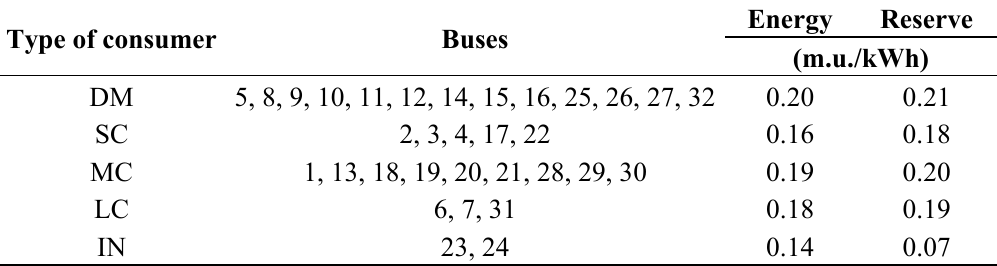
Table 2. Consumers’ characteristics and bid